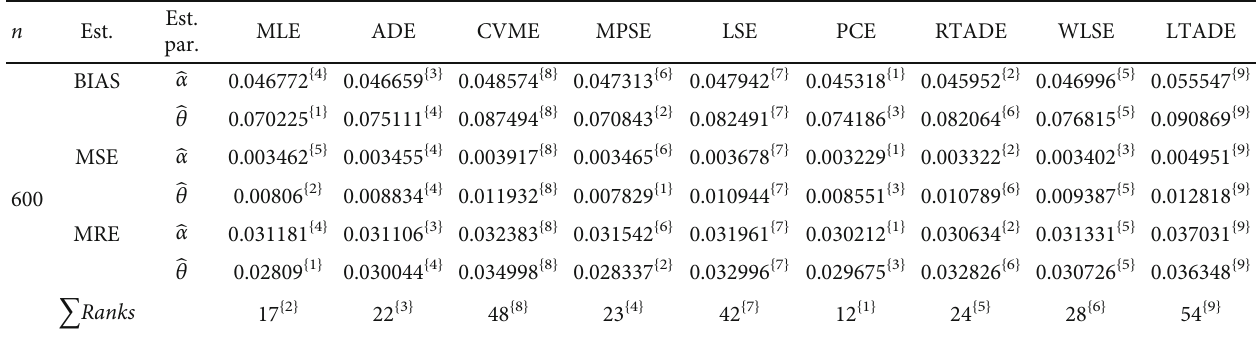
A sorted random sample from the suggested